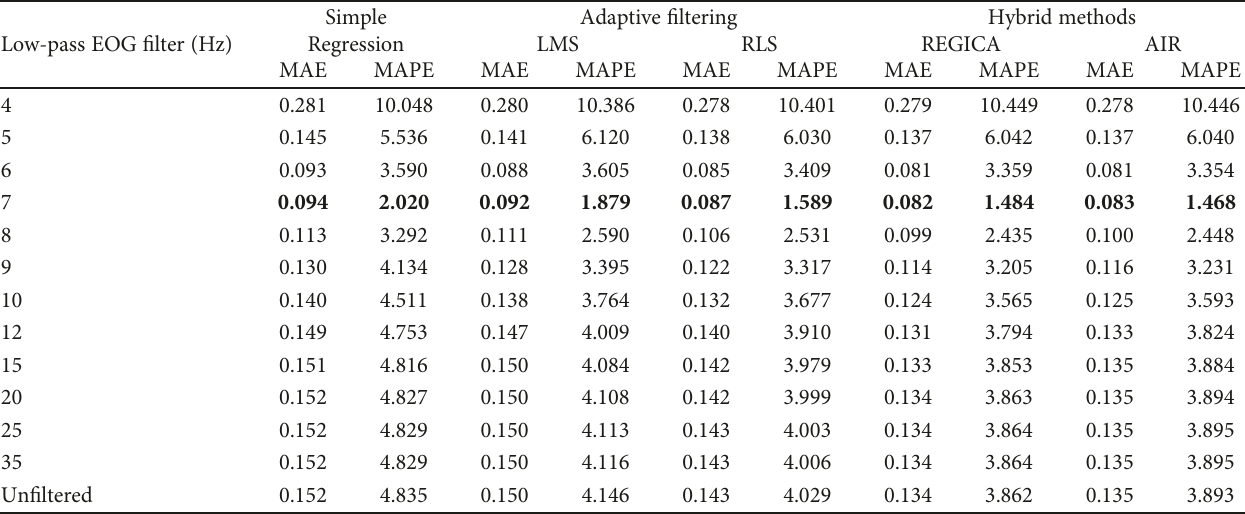
Table 7: Mean absolute error (MAE) and mean absolute percentage error (MAPE) values in theta frequency band (mean of all EEG channels and mean of all simulated subjects).